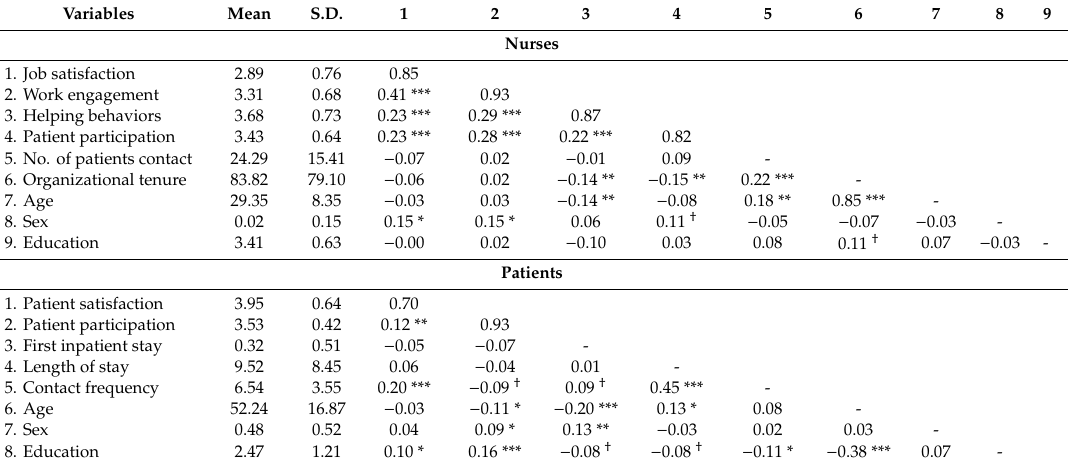
Table 3. Means, standard deviations, correlations, and internal consistency